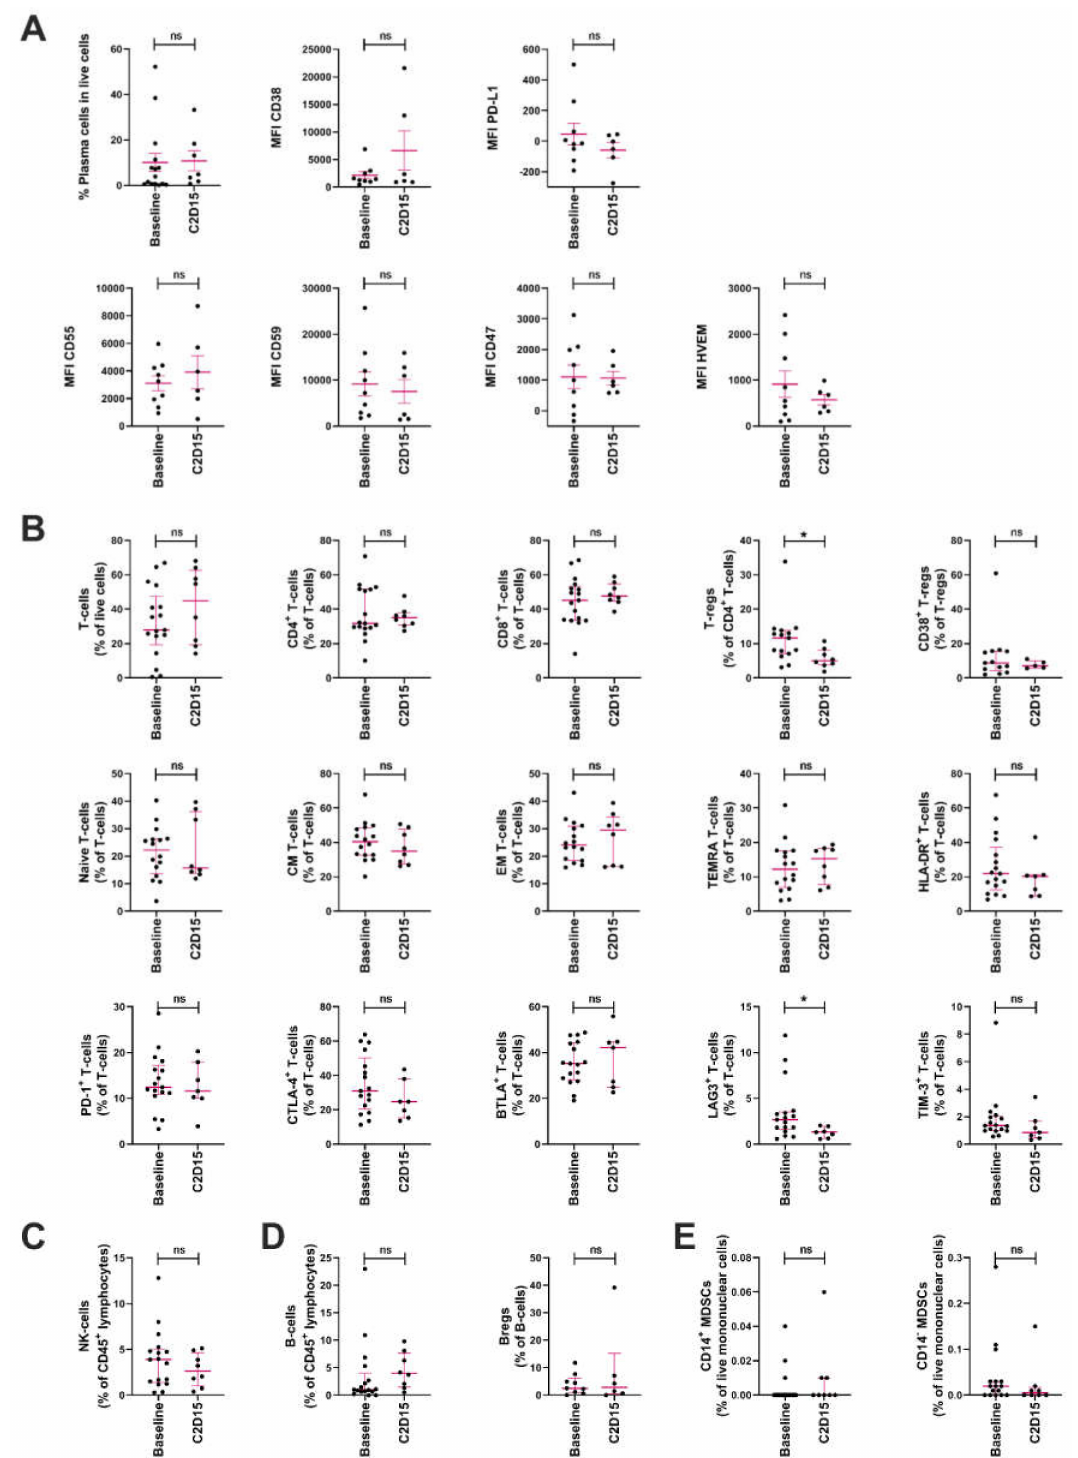
Figure 2. Effect of durvalumab and daratumumab treatment on the frequencies and characteristics of tumor cells and immune cells. Frequencies and characteristics of tumor cells and immune cells were assessed by flow cytometry in BM samples obtained from patients at study entry (baseline; n = 17) and after 6 weeks of treatment with daratumumab and durvalumab (C2D15; n = 8). ( A ) The frequency of plasma cells, as well as their cell surface expression of CD38, PD-L1, CD55, CD59, CD47 and HVEM. ( B ) The frequency of T-cells and T-cell subsets (CD4 + T-cells; CD8 + T-cells; Tregs; CD38 + Tregs; naïve T-cells; CM T-cells; EM T-cells; TEMRA T-cells; HLA-DR + T-cells; PD-1 + T-cells; CTLA-4 + T-cells; BTLA+ T-cells; LAG3 + T-cells; and TIM-3 + T-cells). ( C ) The frequency of NK-cells. ( D ) The frequency of B-cells and Bregs. ( E ) The frequency of CD14 + and CD14 − MDSCs. Dots